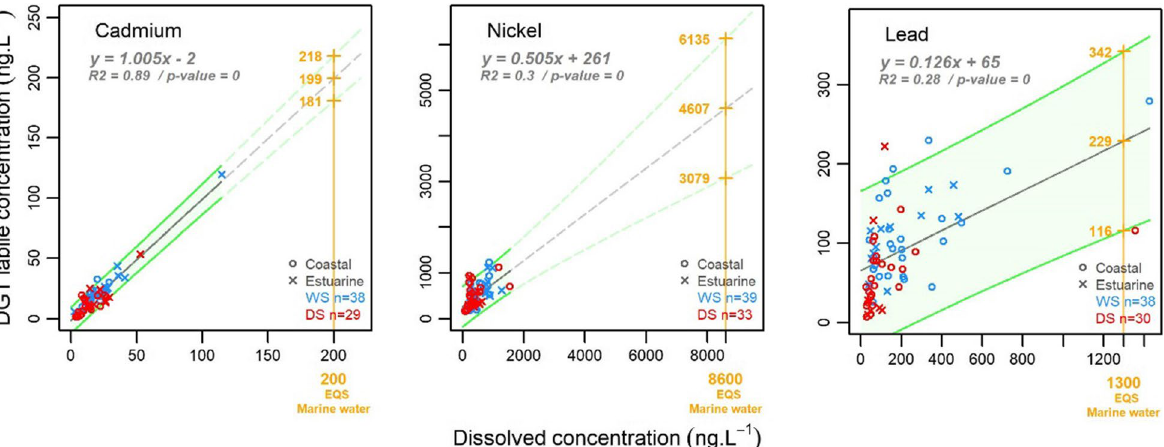
Fig. 3 Linear regression models between dissolved and DGT labile concentrations for the determination of (A)‑EQS DGT : ( a ) cadmium, ( b ) nickel and ( c ) lead. The regression line (black line) and its corresponding prediction interval ( ± 95%; green lines and shaded green area) are shown. The shaded area corresponds to the range of validity of the model, defined on the horizontal axis, indicating that for a measured dissolved concentration value within the range of validity of the model, 95% of the DGT results will be between these 2 lines. WS wet season, DS dry season